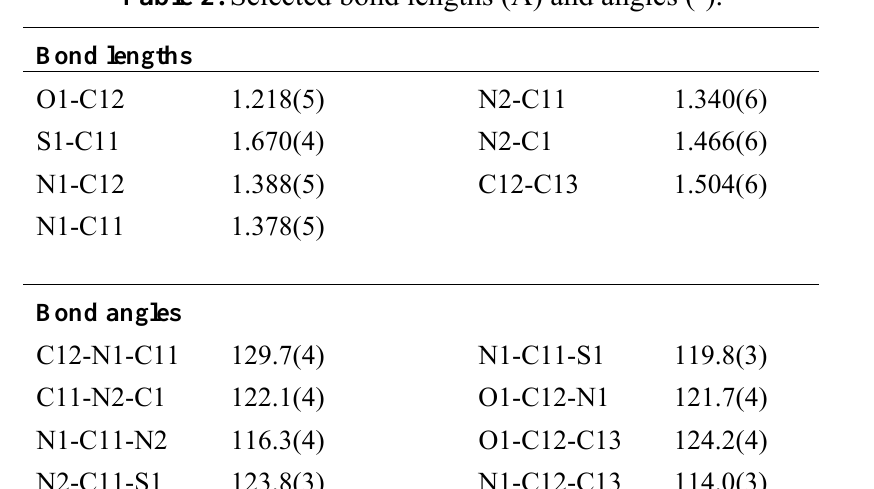
Table 2. Selected bond lengths (Å) and angles ( o